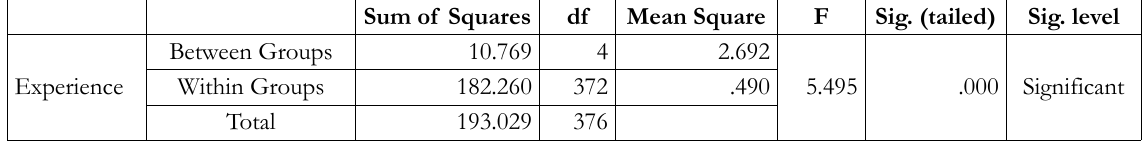
Table 11. One-way ANOVA of students’ responses, according to classification